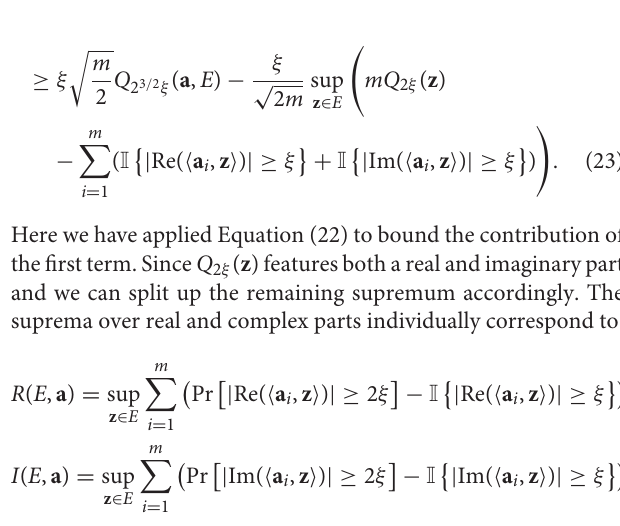
323 and n 1295 (real-valued signals) from random orthogonal array measurements and their generic = = 255 and n 1021 (complex-valued signals) from random time-frequency shifted Alltop = =